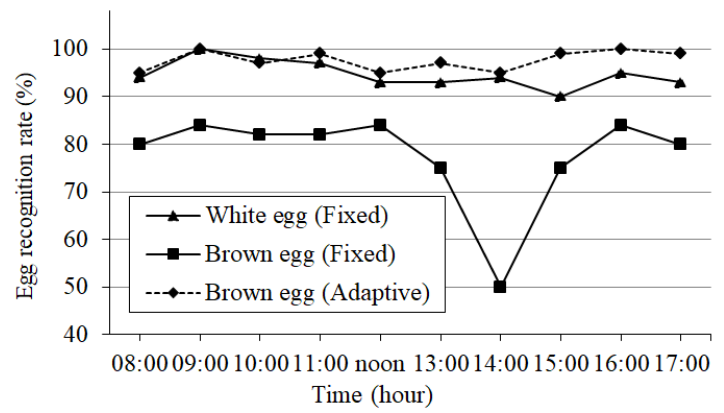
Figure 11. Egg detection rates over different time periods.